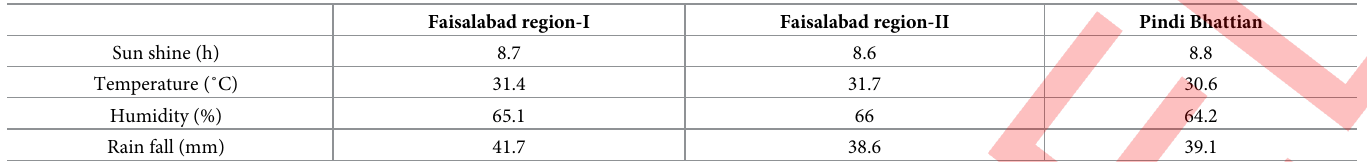
Table 1. Meteoriologiacl average data collected from three different regions.